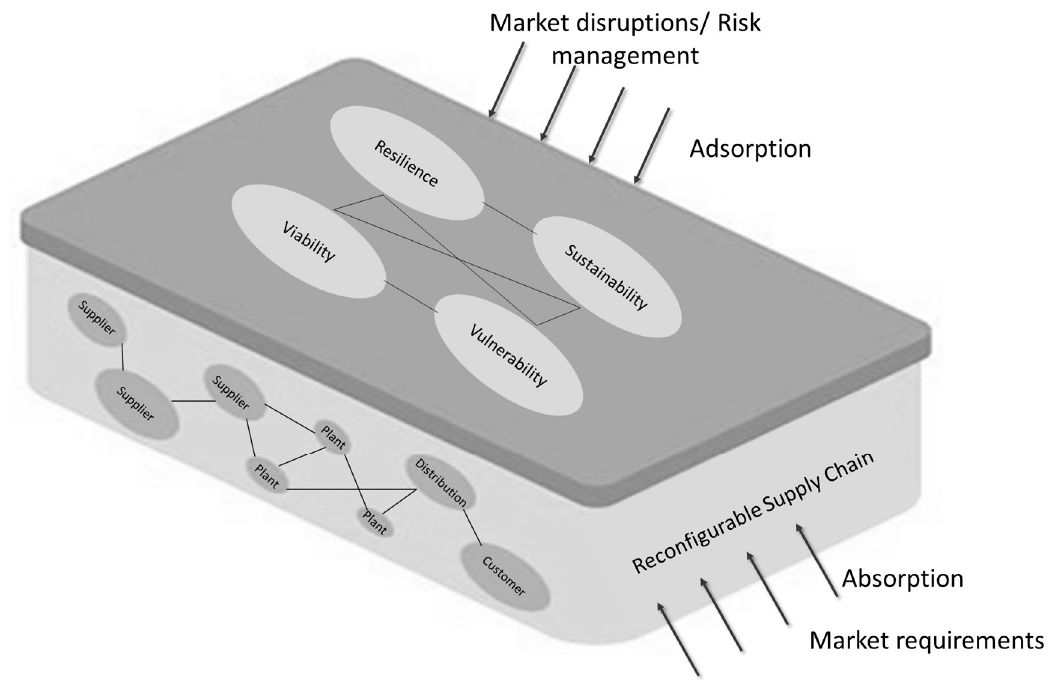
Figure 6. Sponge effect in Reconfigurable Supply Chain.